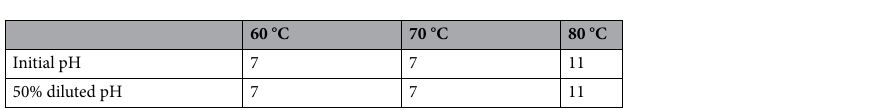
Table 1. The solution pH initial and after diluted with distilled water for the spectroscopic measurements of 30 µM solution concentration.